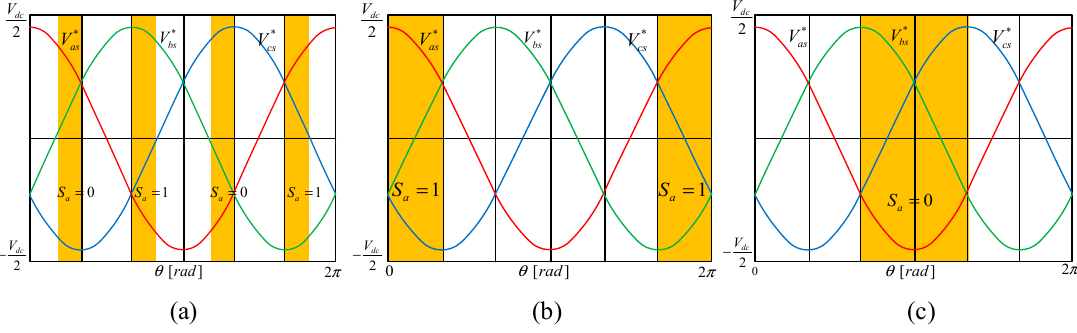
◦ DPWM; ( b ) 120 ◦ (on) DPWM; ( c ) 120 ◦ (off) DPWM. Figure 4. Discontinuous PWM technique: ( a ) 30 ° DPWM; ( b ) 120 ° (on) DPWM; ( c ) 120 ° (off) DPWM.